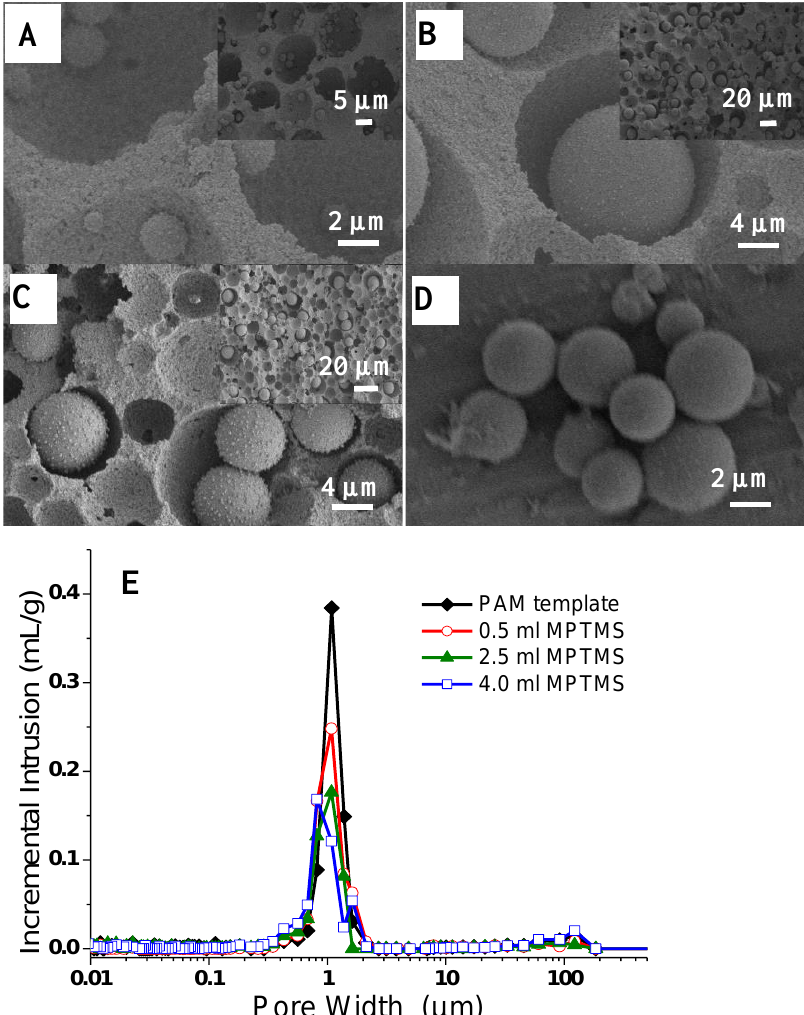
Figure 7. Silica microspheres were synthesised inside the PAM monolith (see Table 1, templated from 60 v / v % O/W emulsion) using ( A ) 0.5, ( B ) 2.5 and ( C ) 4.0 cm 3 of MPTMS in the reaction. ( D ) Silica microspheres obtained after calcining the composite prepared using 2.5 cm 3 of